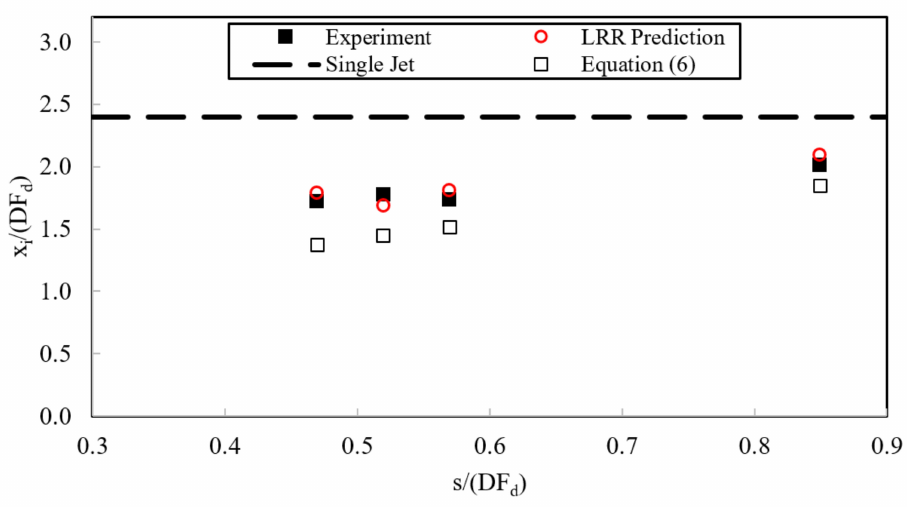
Figure 6. Experimental measurements [19] and numerical results of the normalized impact point